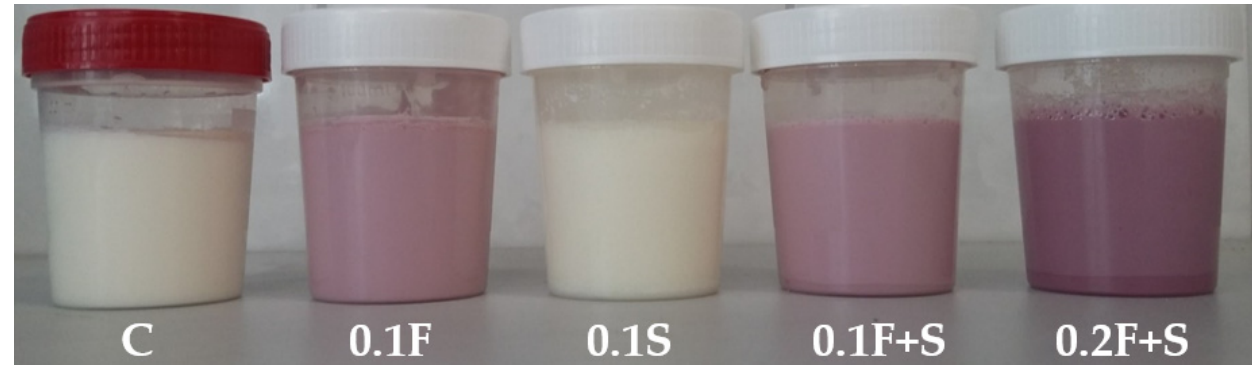
Figure 1. Color of yoghurt samples with different amounts of honeysuckle berries extract and resistant starch preparation after 14 days of storage. C: control, 0.1F: 0.1% addition of the honeysuckle berries extract; 0.1S: 0.1% addition of resistant starch preparation; 0.1F+S: 0.1% addition of the honeysuckle berries extract and resistant starch preparation (each of the additives); 0.2F+S: 0.2% addition of the honeysuckle berries extract and resistant starch preparation (each of the additives).